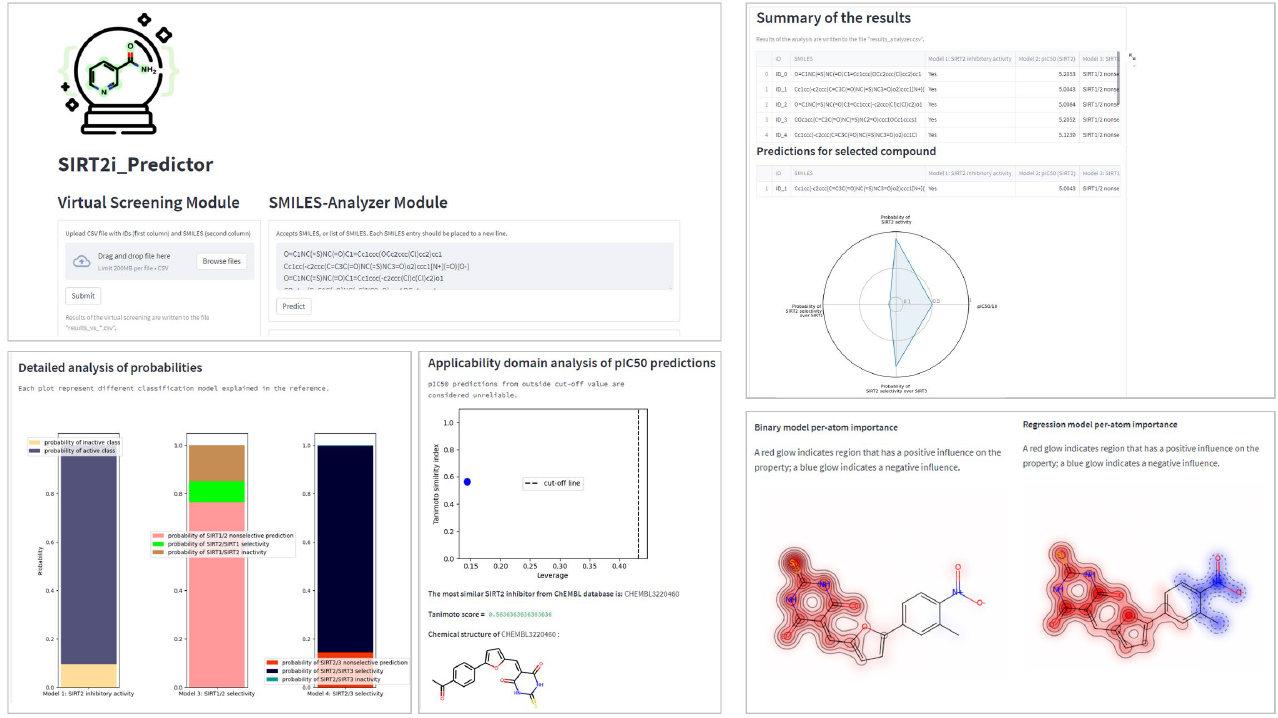
Figure 8. Preview of the main functionalities of SIRT2i_Predictor.